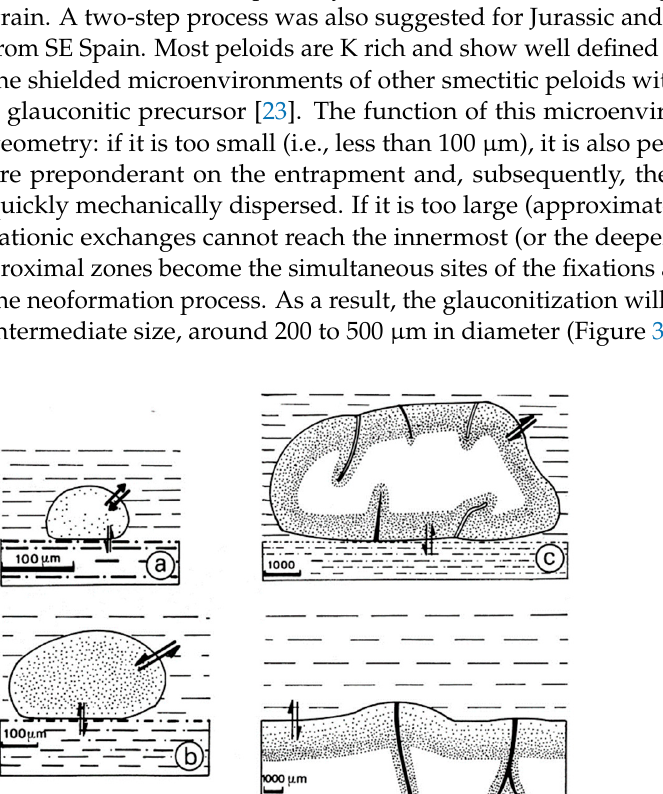
Figure 4. Zonation in a 1-millimeter-wide ellipsoidal fecal pellet. 1: transit sector; 2: mineralogene- sis sector; 3: sector isolated from surrounding environment, after Odin [23]. To this day, the lines of G. Millot’s introduction to the book of Odin [4] are still rel- evant: “We understand that the micromilieu found at the center of the grain or pellets presents physicochemical and biogeochemical characteristics different from those of sea-water where crabs and turbots swim. Now this is of great consequence. For most